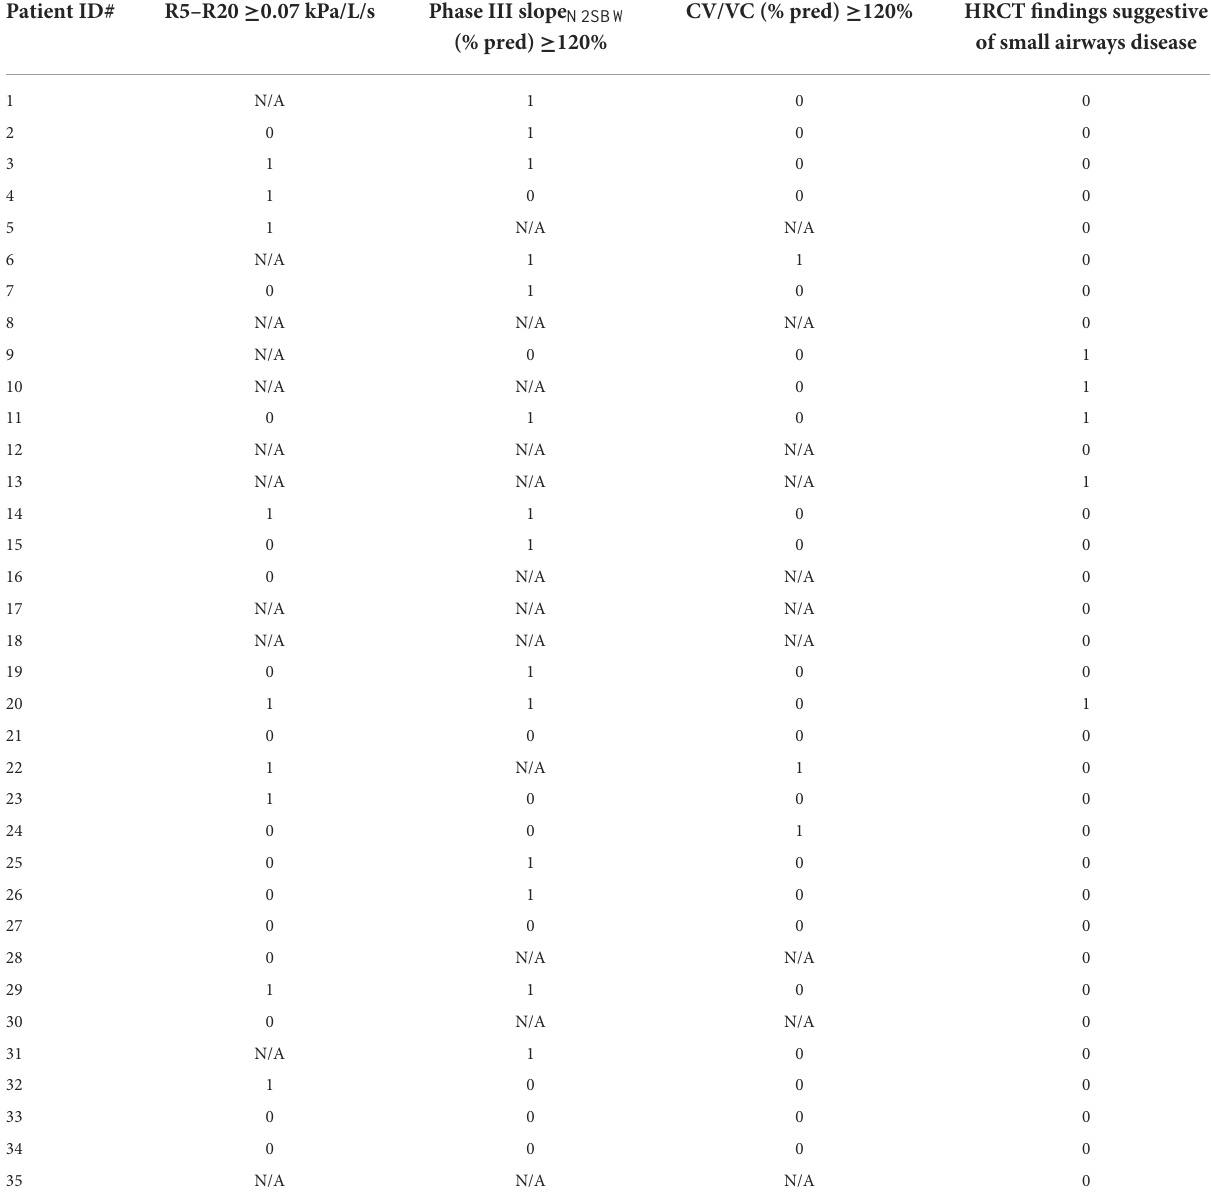
TABLE 1 R5-R20, phase III slope N2SBW and CV/VC tests in SSc